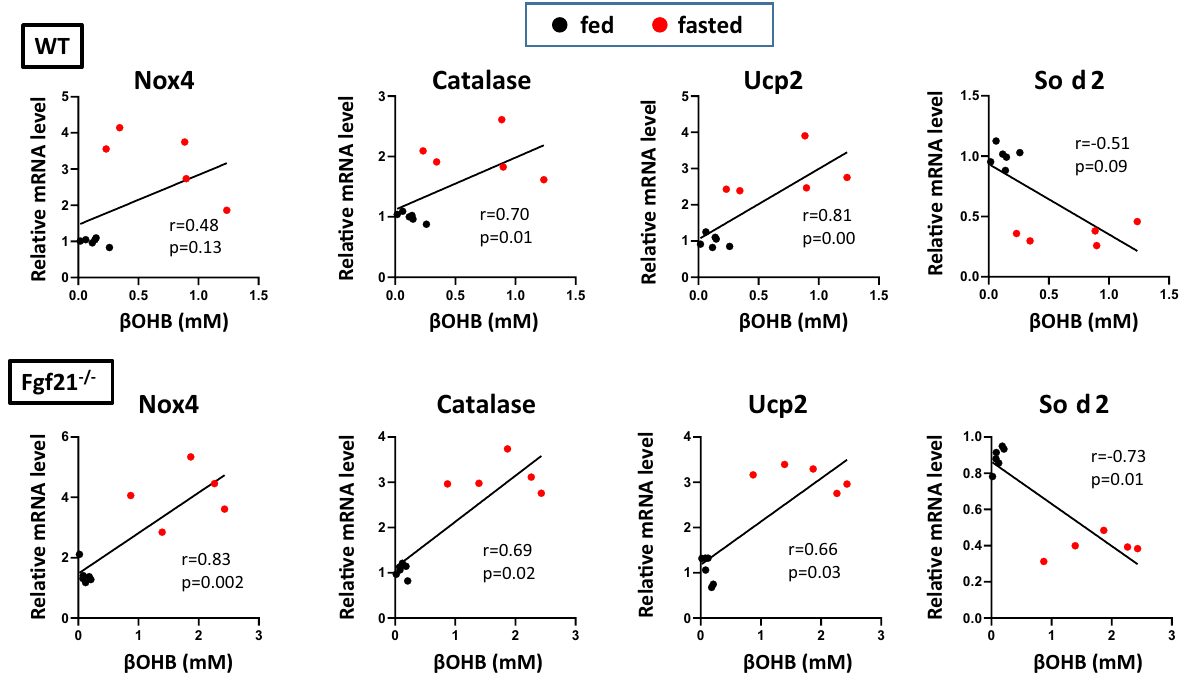
Figure 6. Correlations of the oxidative stress response gene expression with βOHB in Fgf21 −/− mice hearts. Linear gene expression values for Nox4, catalase, Ucp2 and Sod2 are shown in the y -axis in relative fluorescence units, whereas βOHB concentrations are shown in the x -axis. Pearson’s correlation coefficient and p-value are shown.